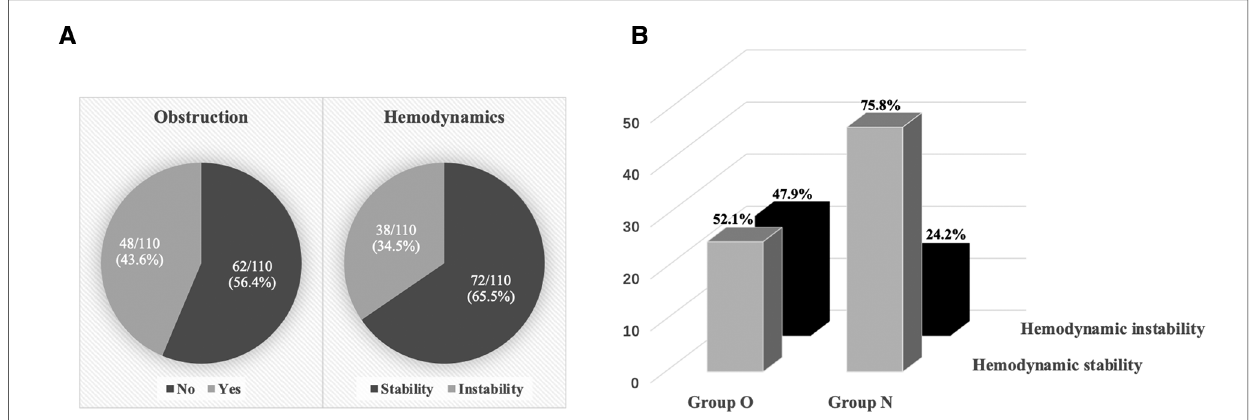
FIGURE 2 Hemodynamic status during anesthesia induction. ( A ) 48 (43.6%) myxomas obstructed the tricuspid or mitral valve, and 38 (34.5%) experienced hemodynamic instability during anesthesia induction. ( B ) Hemodynamic stability and hemodynamic instability between the two groups.